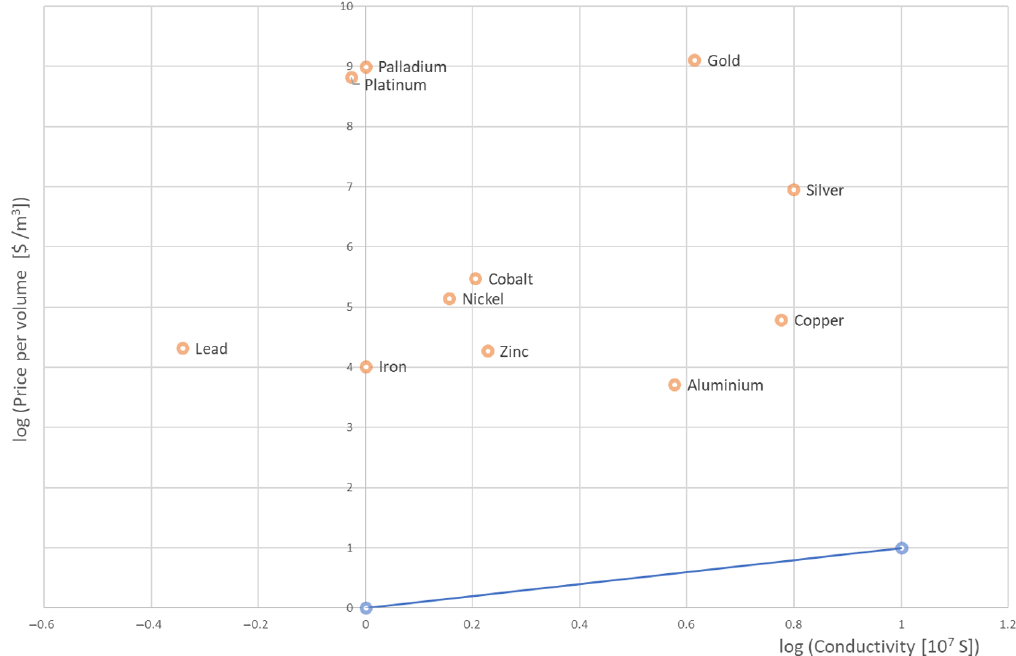
Figure 4. Constructed Ashby map for the considered example, log ( p V ) vs. log ( σ ) with an indicated line.